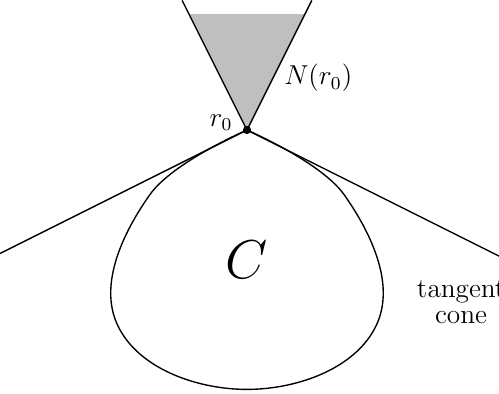
Figure 1: The tangent cone and the normal cone to a convex body C . Figure 1. The tangent cone and the normal cone to a convex body C